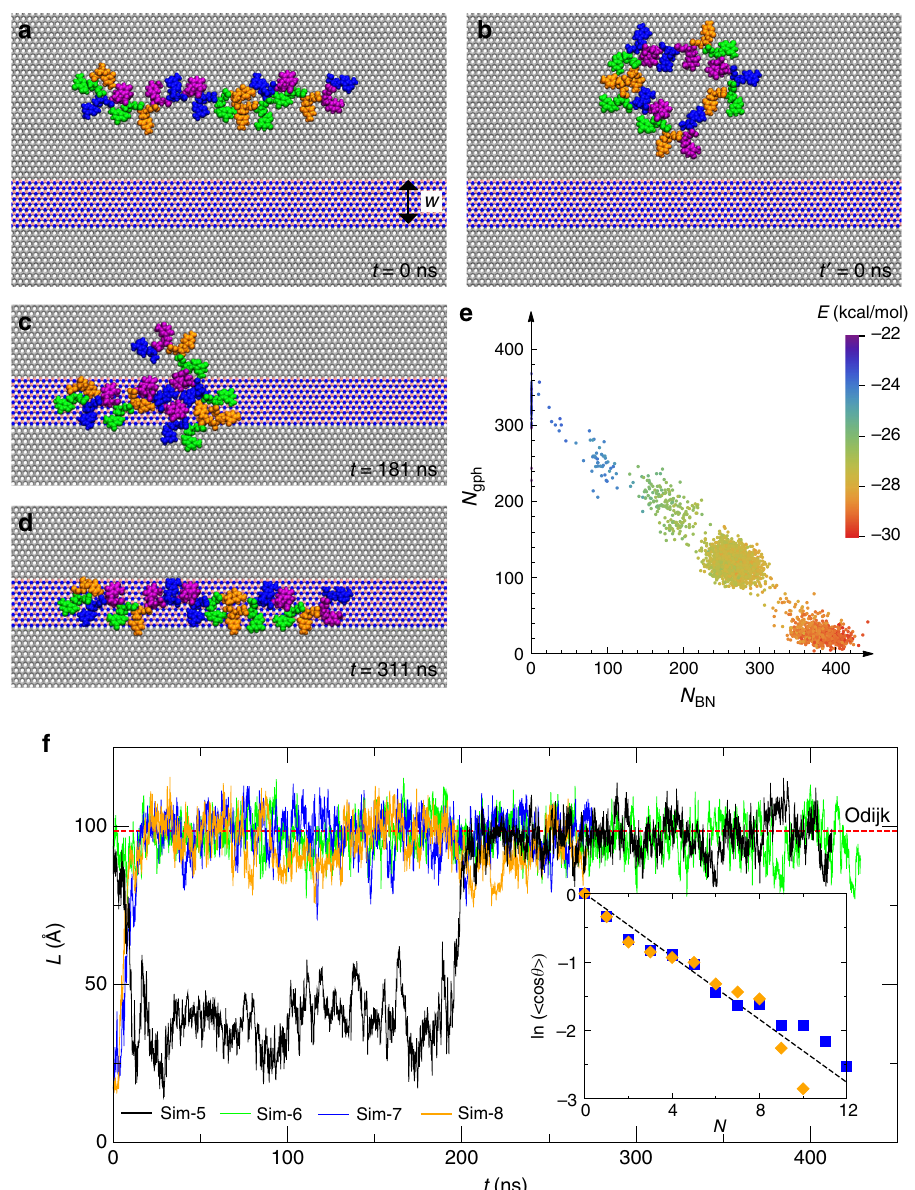
Fig. 2 Modeling ssDNA motion on the graphene/h-BN/graphene heterostructure. a The initial linear conformation of ssDNA on the graphene domain (Sim-5 and Sim-6). b The initial circular conformation of ssDNA on the graphene domain (Sim-7 and Sim-8). c , d Conformations of ssDNA at 181 and 311 ns, respectively (Sim-5). e A scatter plot of numbers of atoms in the heterostructure that are in contact with ssDNA. The color shows the van der Waals interaction energy per nucleotide. f End-to-end distance for ssDNA during all four simulations. In-set : exponential decay of the correlations between two unit tangential vectors along the ssDNA backbone and separated by N nucleotides in-between. Results were extracted from simulations of ssDNA on graphene only (Sim-3, blue squares) or h-BN only (Sim-4, orange